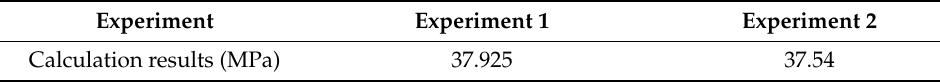
Table 8. Calculated interface pressure gauge for Experiments 1 and 2.